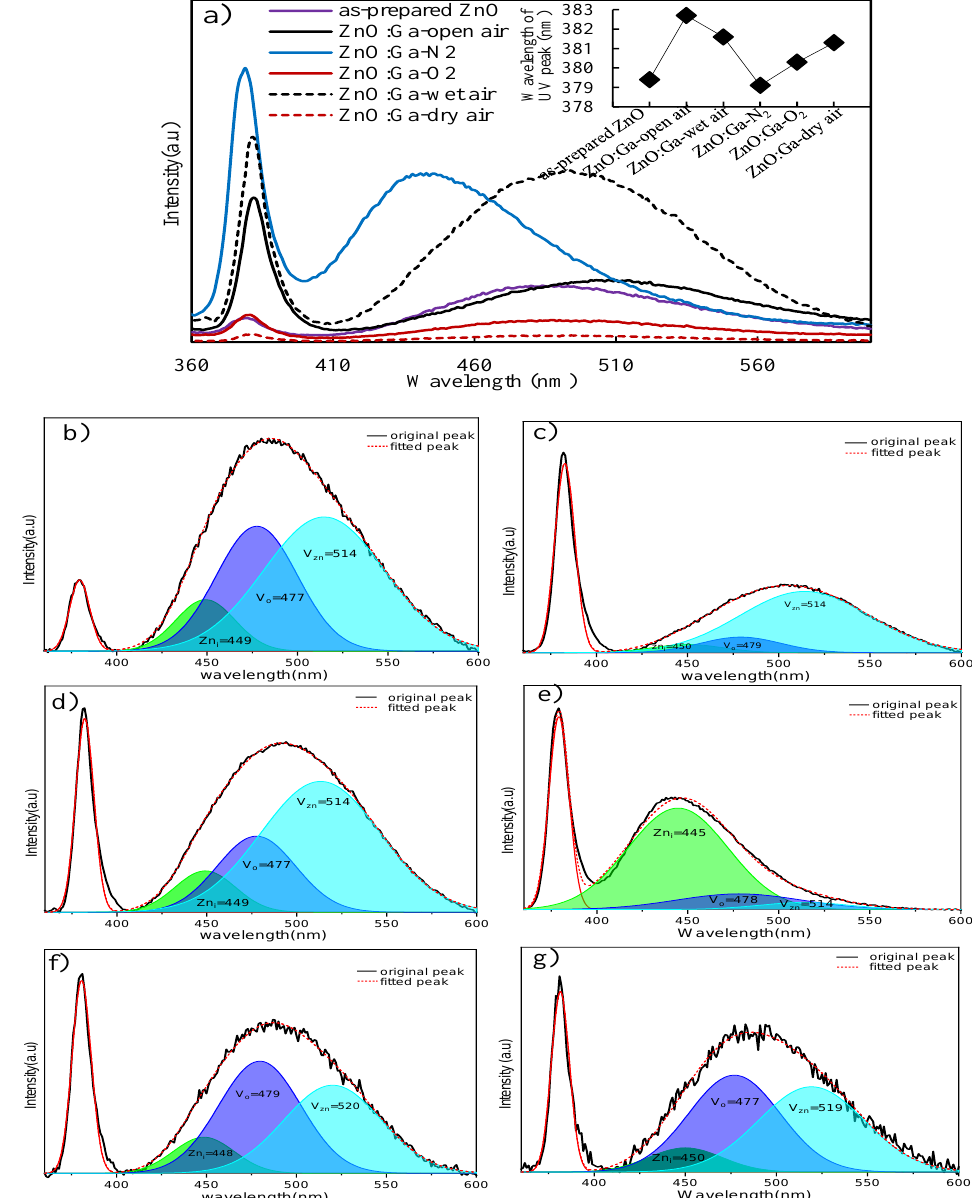
Figure 6. ( a ) Photoluminescence (PL) spectra, and deconvoluted PL spectra of ( b ) as-prepared ZnO, ( c ) ZnO:Ga-open air, ( d ) ZnO:Ga-wet air, ( e ) ZnO:Ga-N 2 , ( f ) ZnO:Ga-O 2 , and ( g ) ZnO:Ga-dry